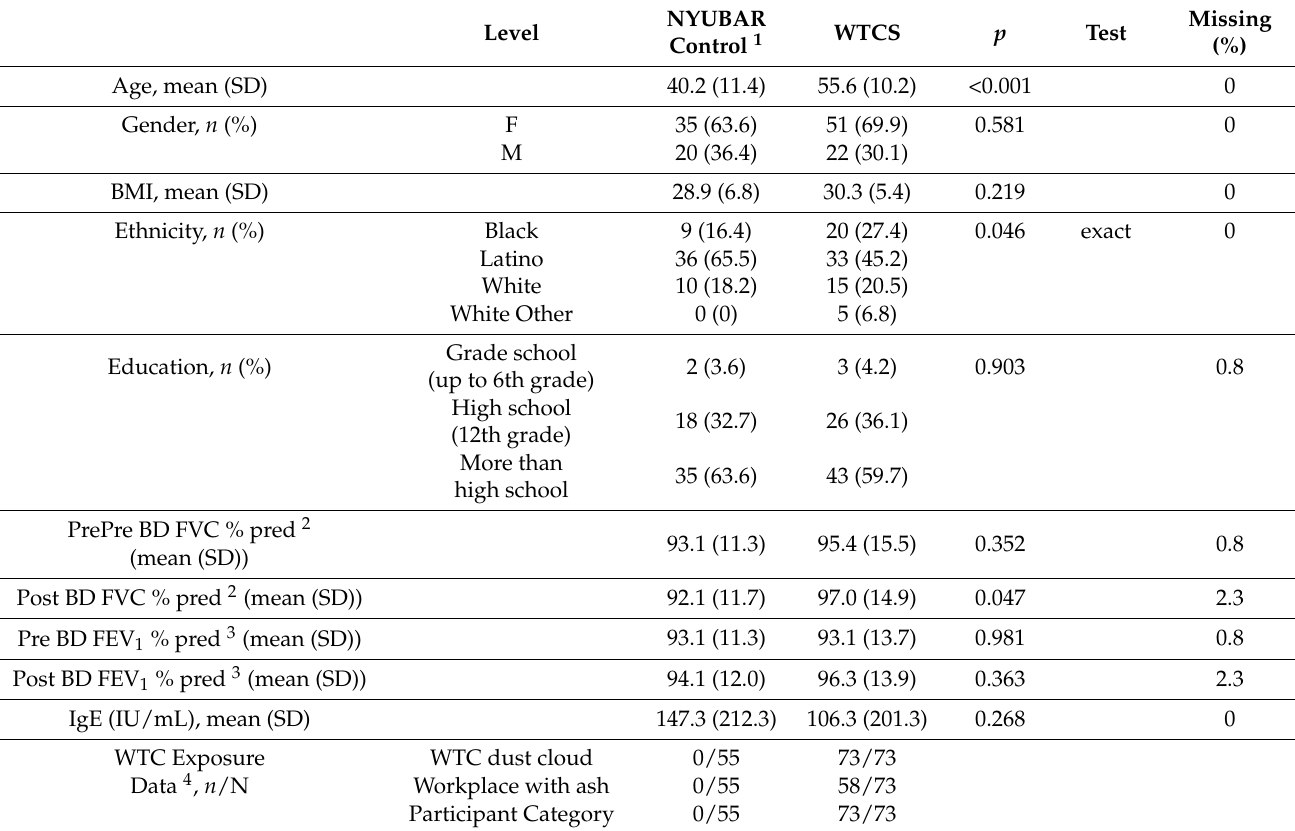
Table 1. Characteristics of all study